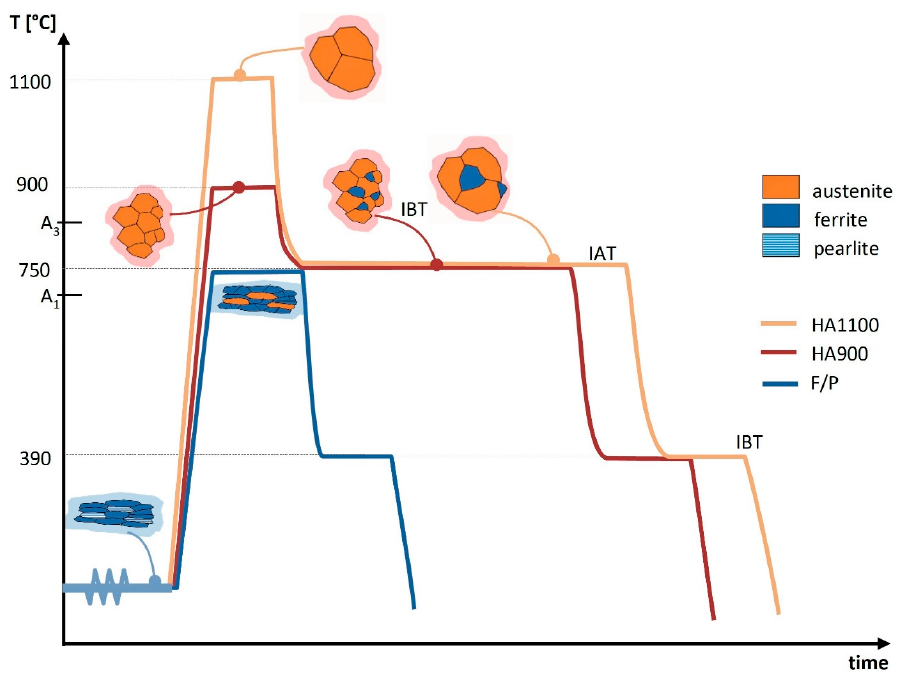
Figure 2. Schematic representation of heat treatments employed to obtain multiphase TRIP aided steels. Table 1. Parameters used for the heat treatment cycles and austenite grain size after austenitization.